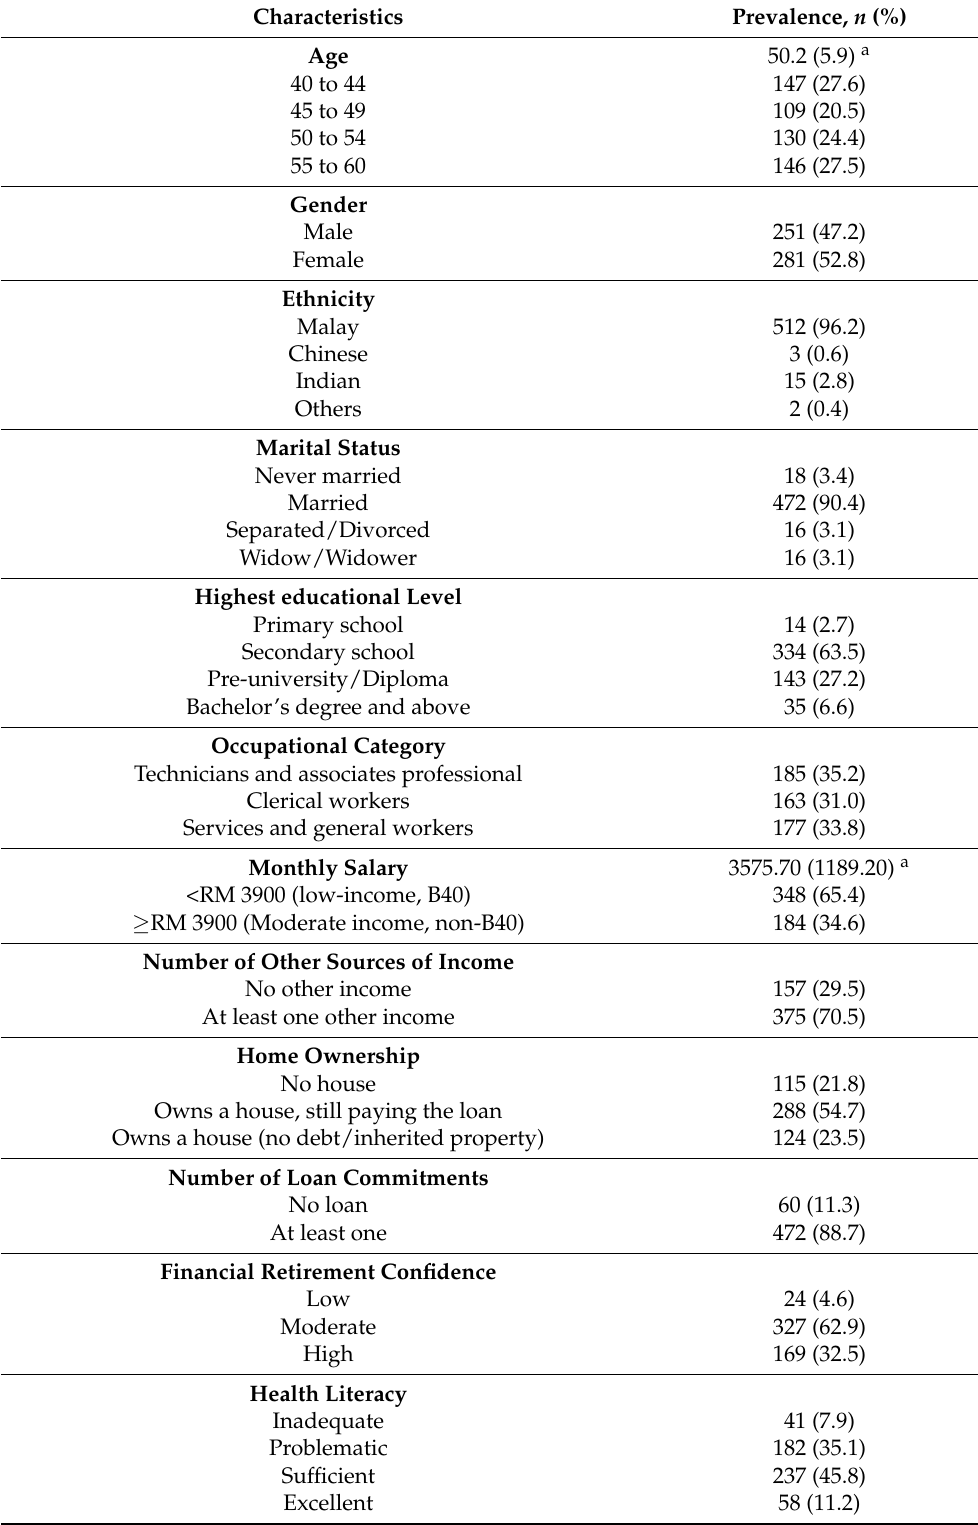
Table 1. Socio-demographic and Health-related Characteristics of the Participants (N =